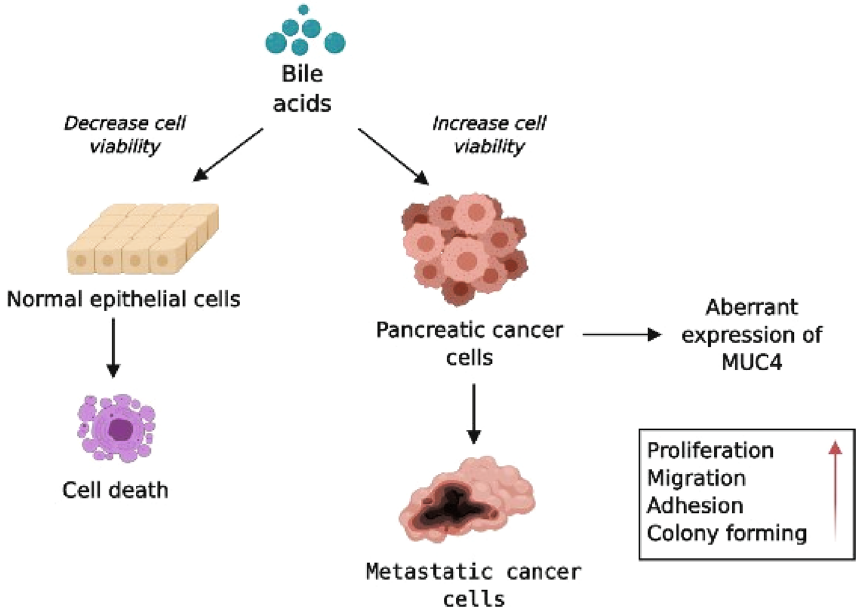
Figure 8. Schematic diagram of the effect of bile acids. Bile acids (BAs) decrease the cell viability of normal pancreatic ductal cells and induce cell death in order to avoid malignant transformation. In the case of pancreatic ductal adenocarcinoma (PDAC) bile promotes the tumorigenic potential of the cancer cells in which the increased expression of MUC4 plays essential